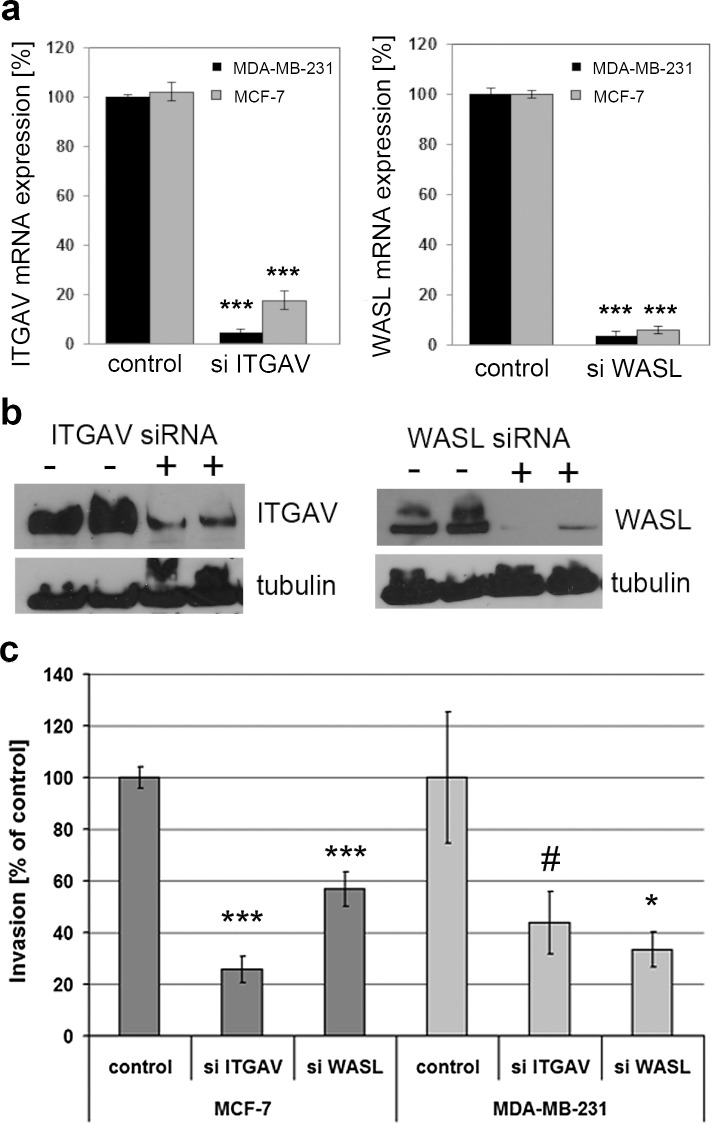
siRNA-mediated depletion of WASL or ITGAV reduces matrigel invasiveness of MCF-7 and MDA-MB-231 cells.(a) Confirmation of successful siRNA knockdown of ITGAV (left panel) and WASL (right panel) by qPCR. N = 4, ***P<0.001. (b) Confirmation of successful siRNA knockdown of integrin-αV and WASL at the protein level by Western blotting. See Fig 3E–3G for details. (c) ITGAV and WASL-depletion reduces matrigel invasiveness of MDA-MB-231 and MCF-7 cells. N>5, #P = 0.06 (n.s.), *P<0.05, ***P<0.001.